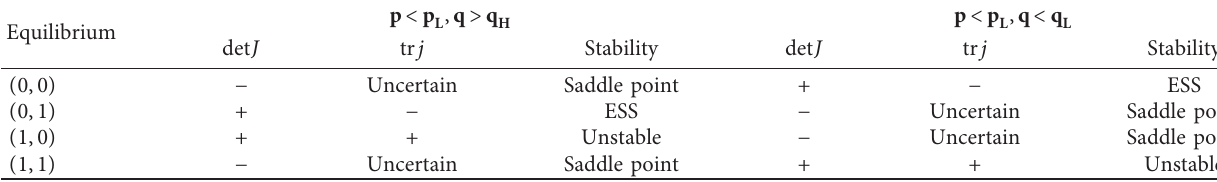
Table 2: Equilibrium point local stability.